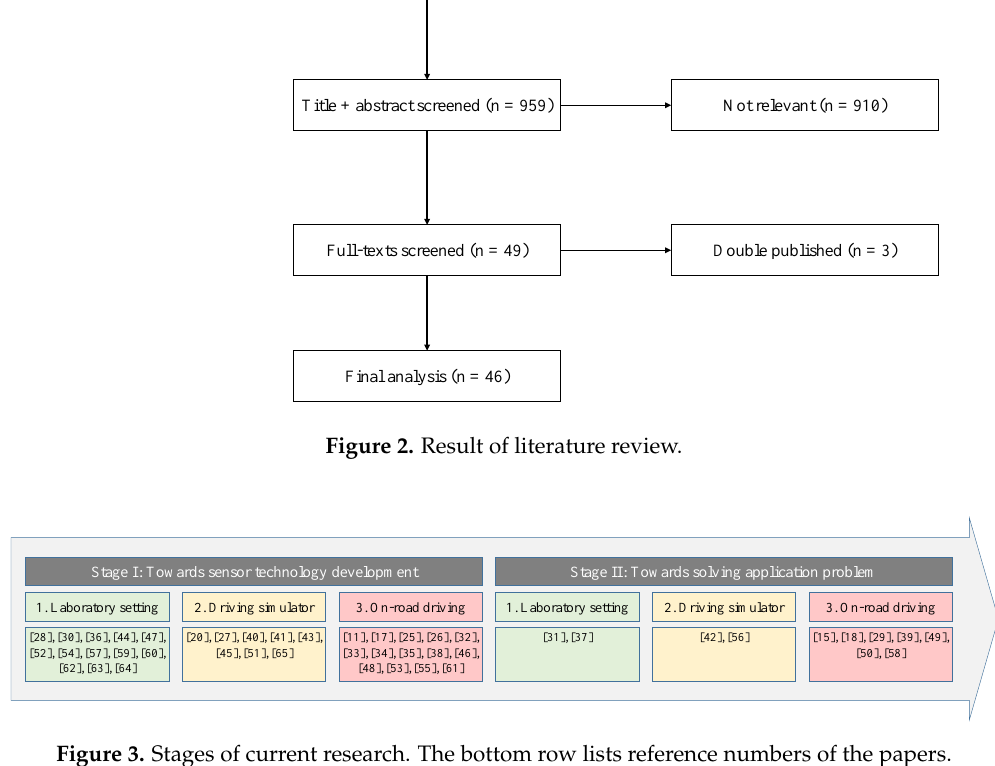
Figure 3. Stages of current research. The bottom row lists reference numbers of the